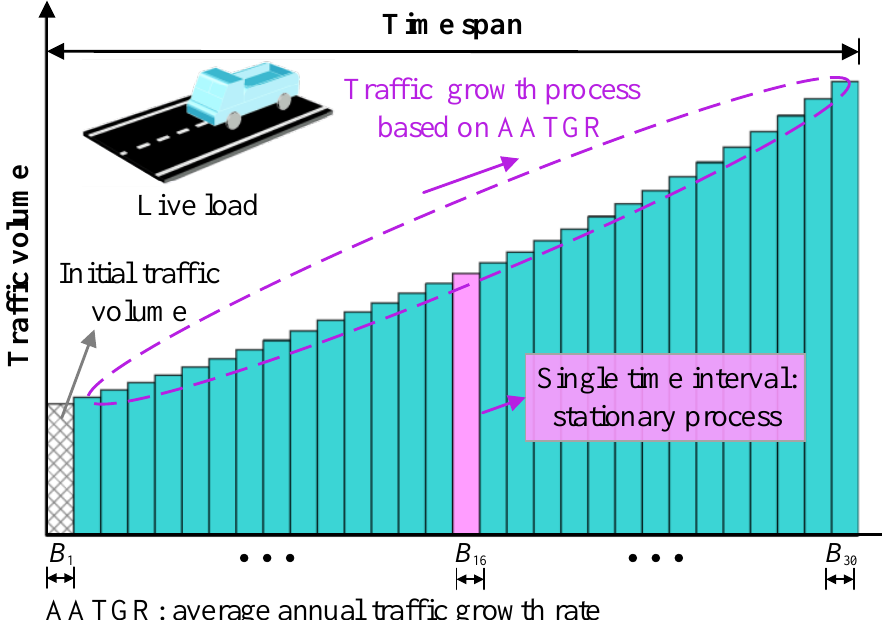
Figure 4. Traffic growth process based on AATGR.